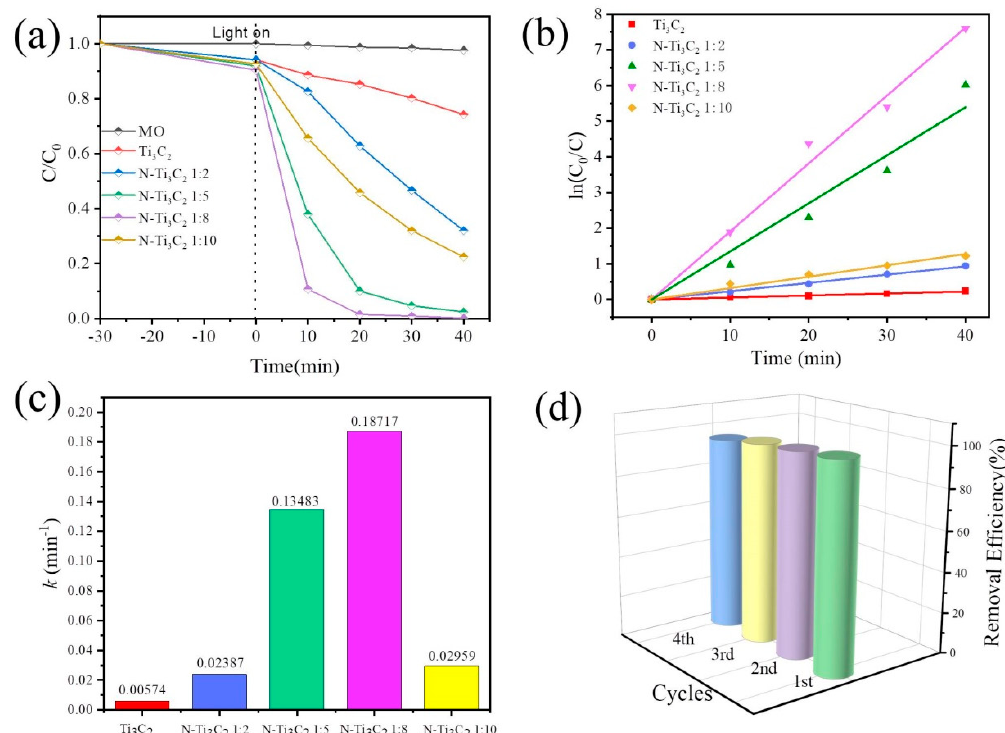
Figure 7. Photo-catalytic activity on ( a ) MO degradation activity, ( b ) pseudo-level diagram of MO degradation, ( c ) kinetic constants of MO degradation, ( d ) reusability of N − Ti 3 C 2 1:8 for MO degradation.